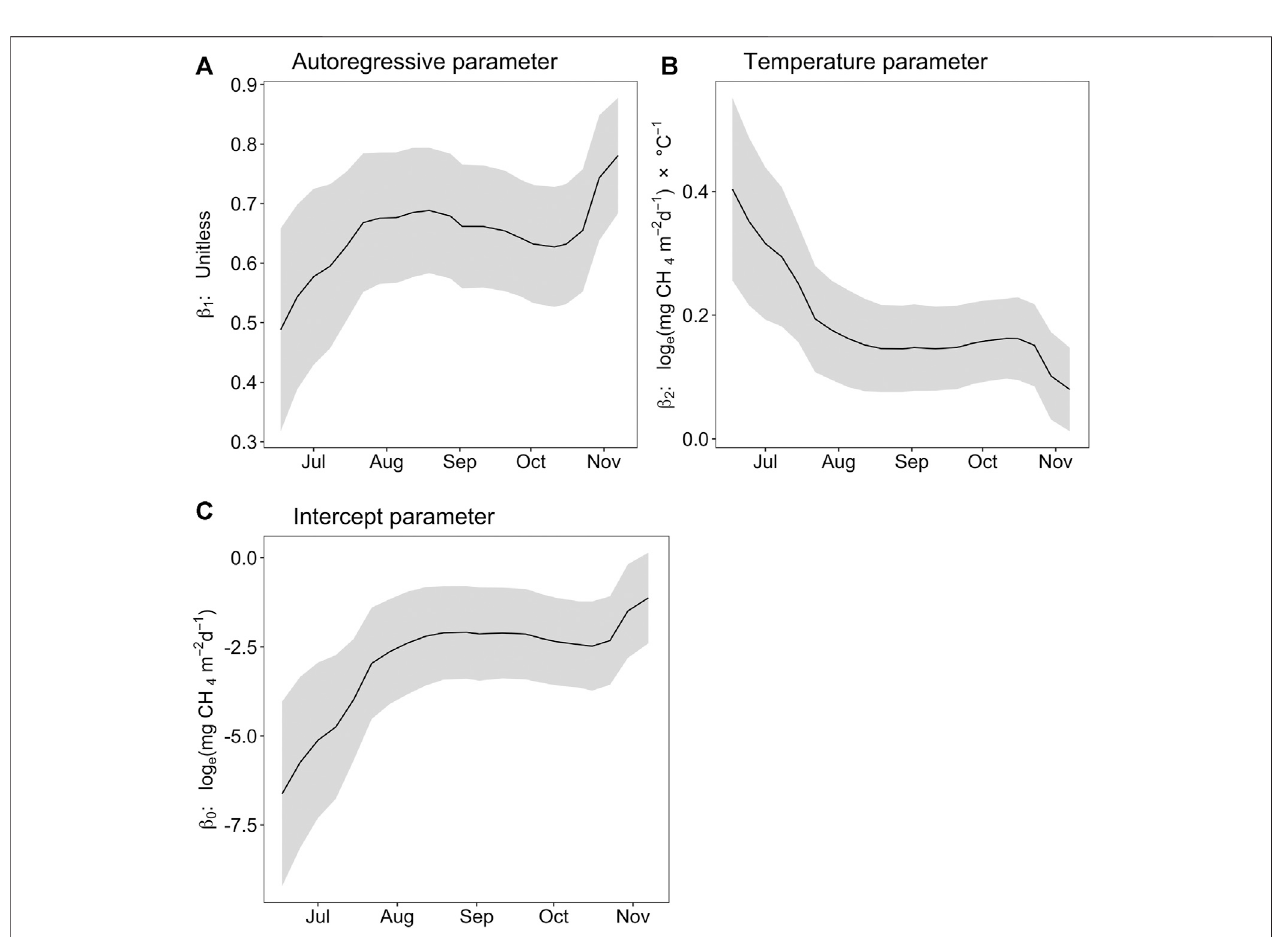
FIGURE 4 | Parameter estimates of β 1 , the autoregressive parameter (A) , β 2 , the sediment-water interface temperature parameter (B) , and β 0 , the intercept parameter (C) of the forecast work fl ow recalibrated with new data. The black line represents the mean of the parameter ensembles, and the grey area represents the standard deviation of the ensembles ( ± 1 S.D.